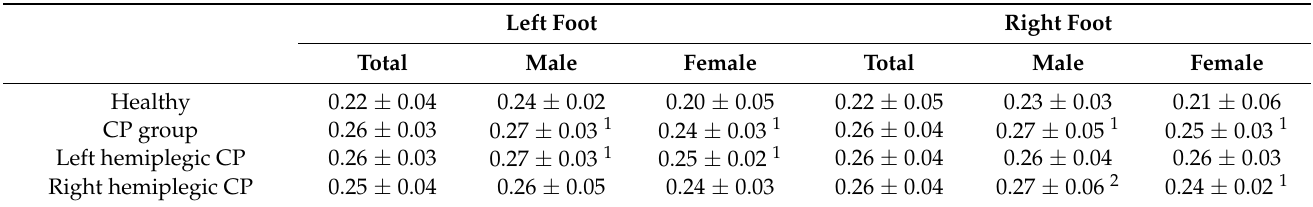
Table 2. Static arch index of both feet for students diagnosed with hemiplegic cerebral palsy and healthy college students. Left Foot Right Foot Total